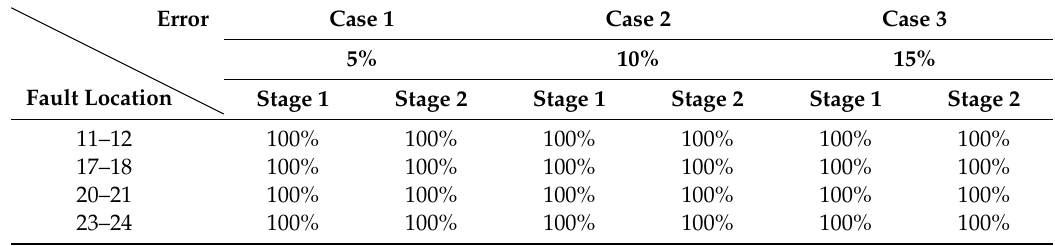
Table 9. Accuracy of the fault location according to load errors (faults in lateral feeder).